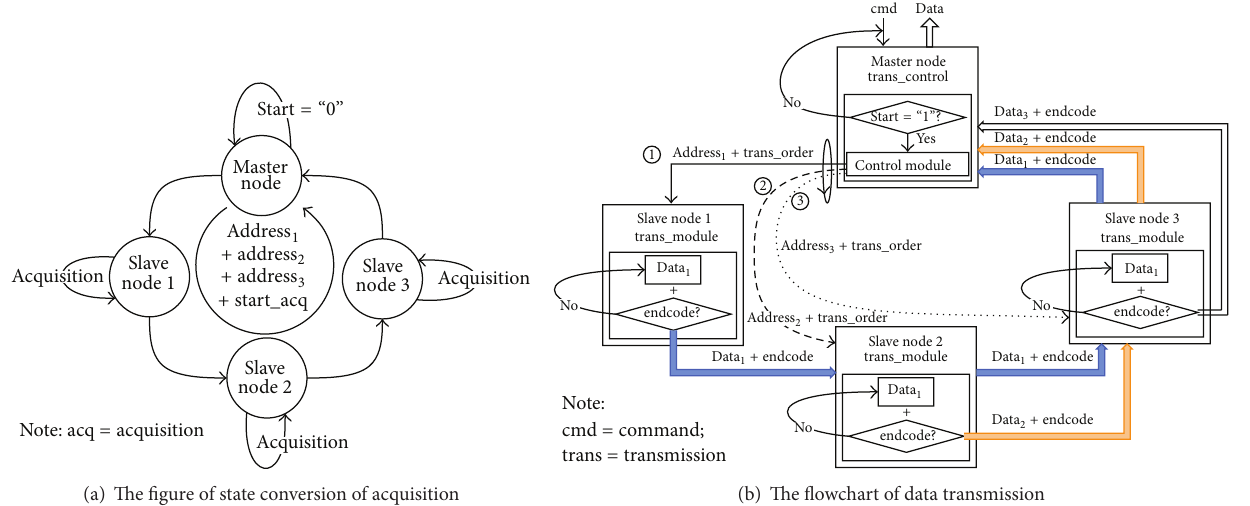
(b) The flowchart of data transmission Figure 5: The flowchart of data acquisition and transmission in the ITM when 𝑛 = 3